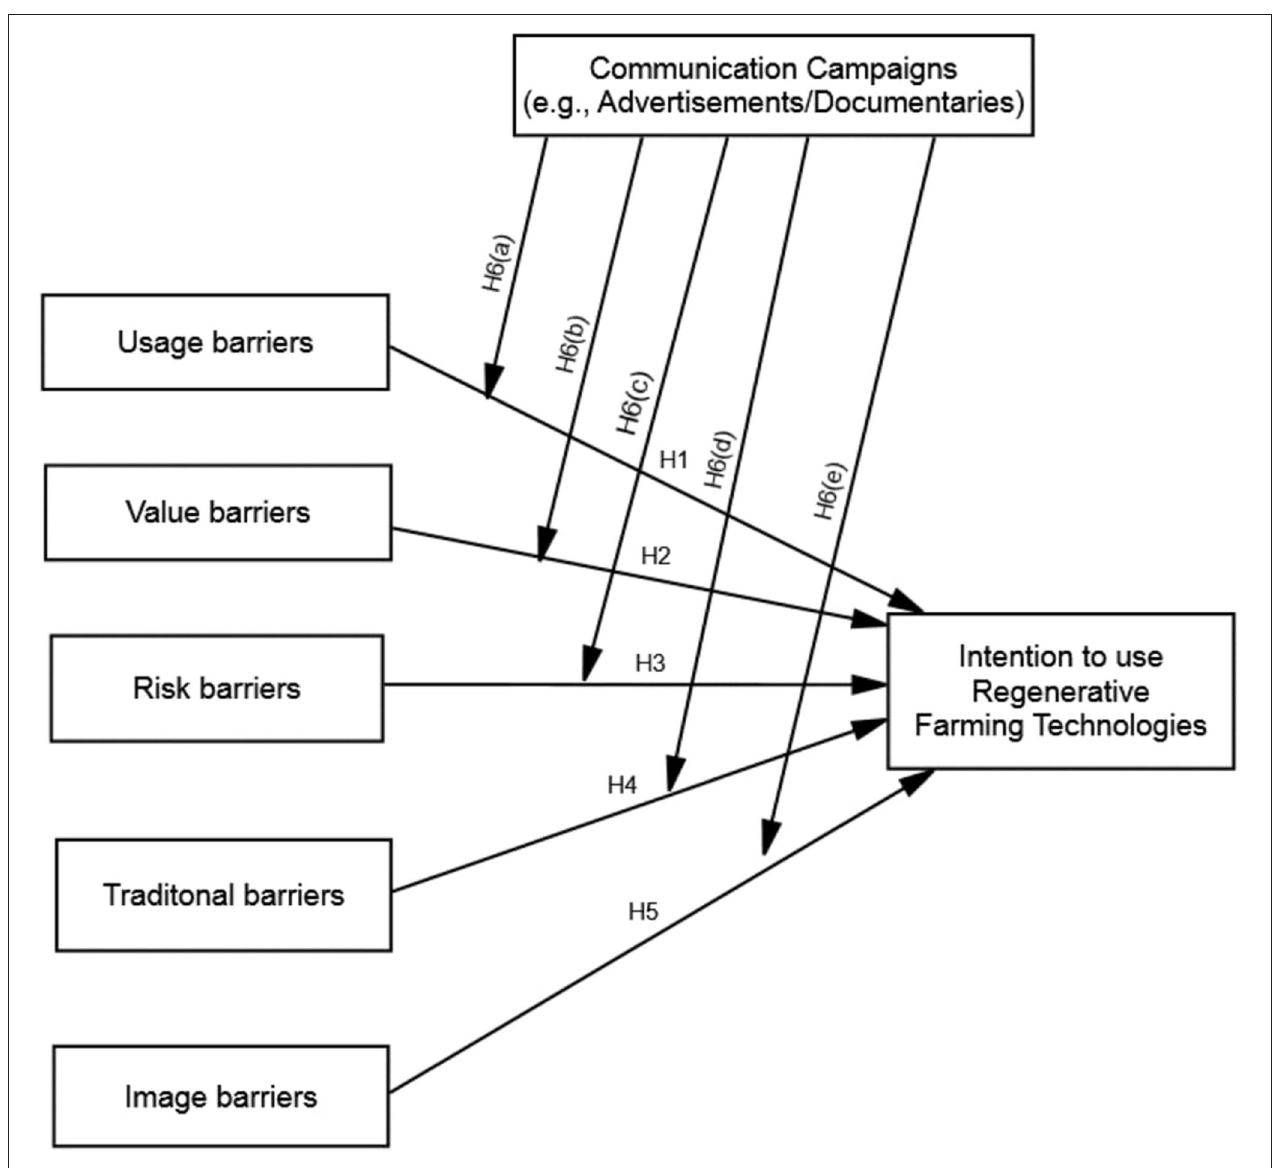
FIGURE 1 | Conceptual